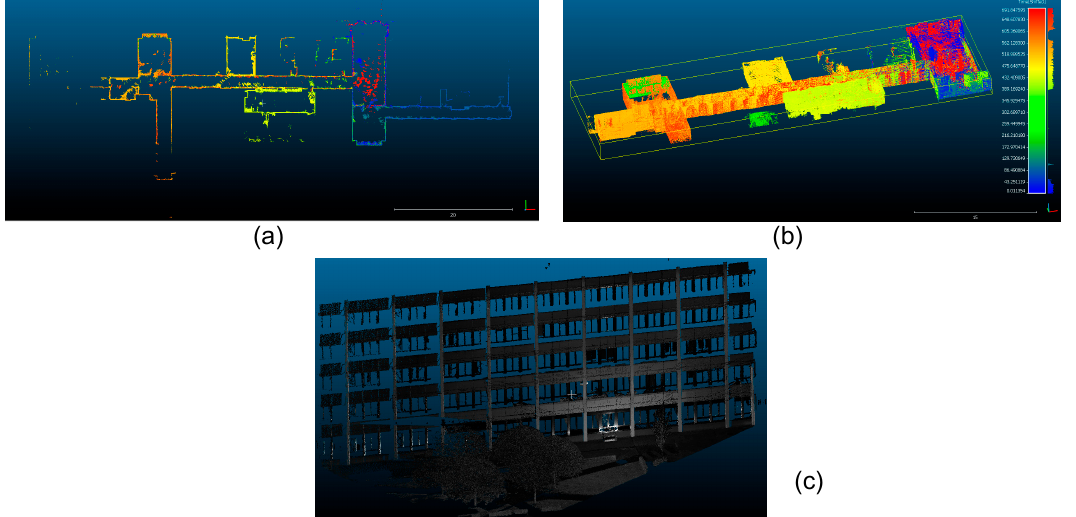
Figure 14. Samples of Zeb point cloud data ( a and b ) and terrestrial point cloud data ( c ).